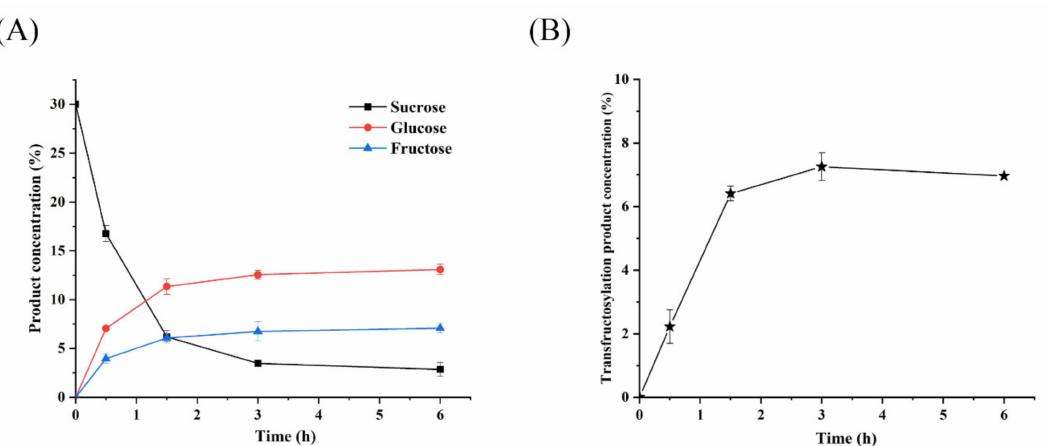
Figure 8. Biotransformation process and conversion ratio of recombinant LS. ( A ) The variation in sucrose, glucose, and fructose concentration in the biotransformation process of Psor-LS. ( B ) The variation in conversion ratio in the biotransformation process of Psor-LS. All of the values are the mean of triplicate